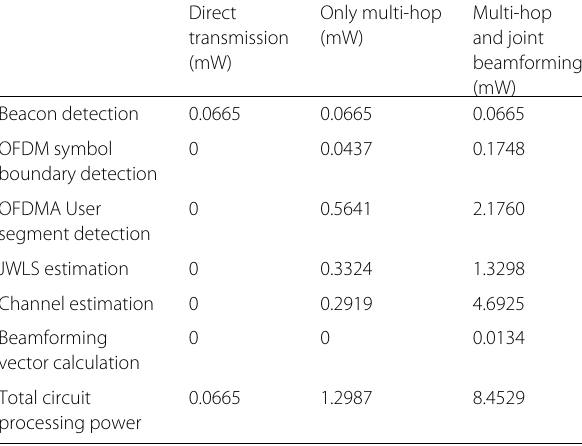
Table 5 Estimated circuit processing power at SNR = 24